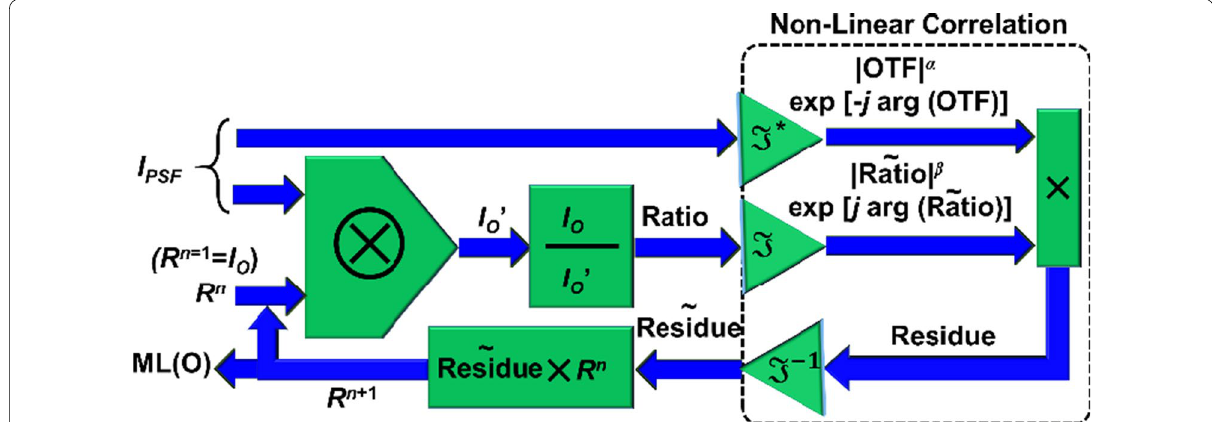
β 1, LRRA becomes = =